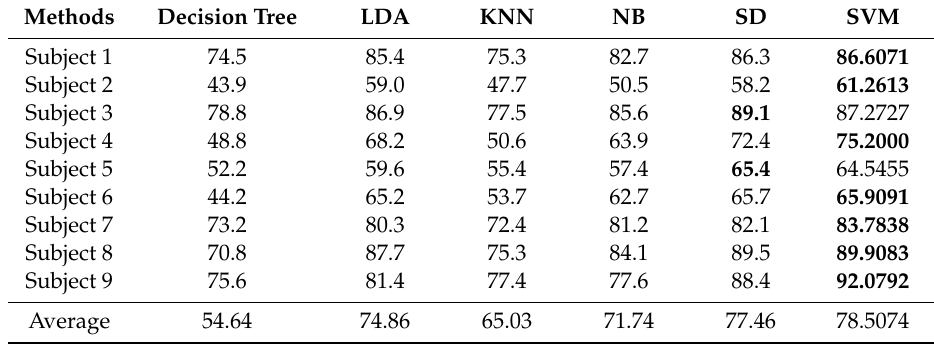
Table 4. Accuracy comparison with other classifiers. The best result for each subject is displayed in bold